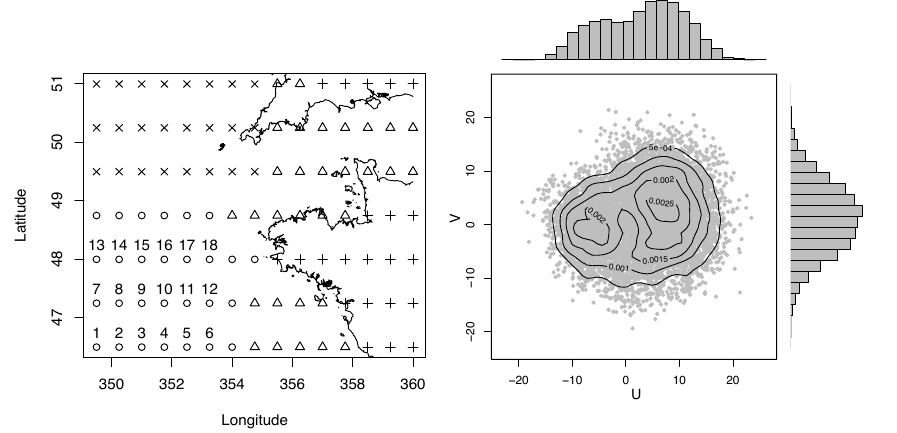
Figure 1. Left: spatial hierarchical clustering of the moving variance associated with wind speed with four clusters (symbols). Right: joint and marginal distribution of { u t ,v t } at the central location 10; contour lines of the estimated joint